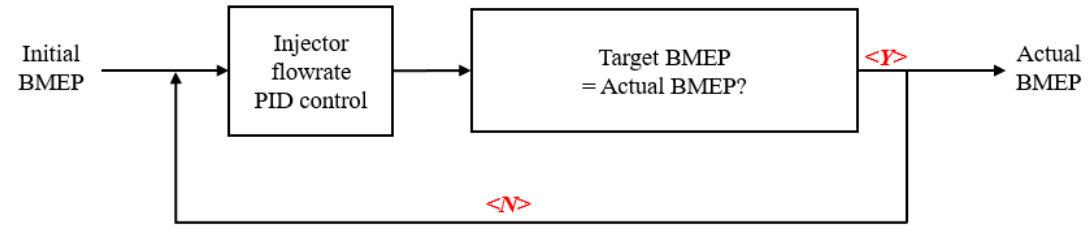
Figure 5. Overall control scheme of the constant brake mean effective pressure (BMEP) controller.